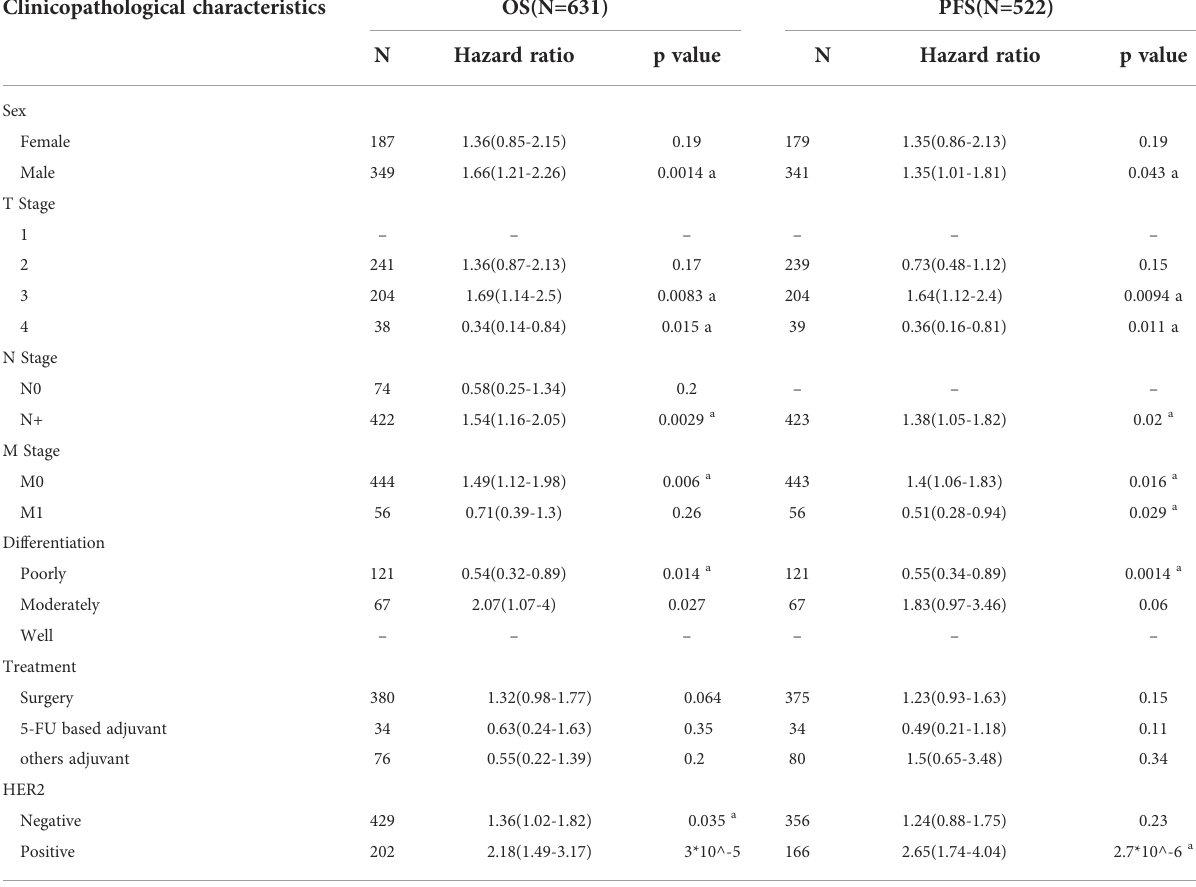
TABLE 2 Correlation of SLFN13 mRNA expression and clinical prognosis in GC with different clinicopathological factors by Kaplan-Meier plotter.